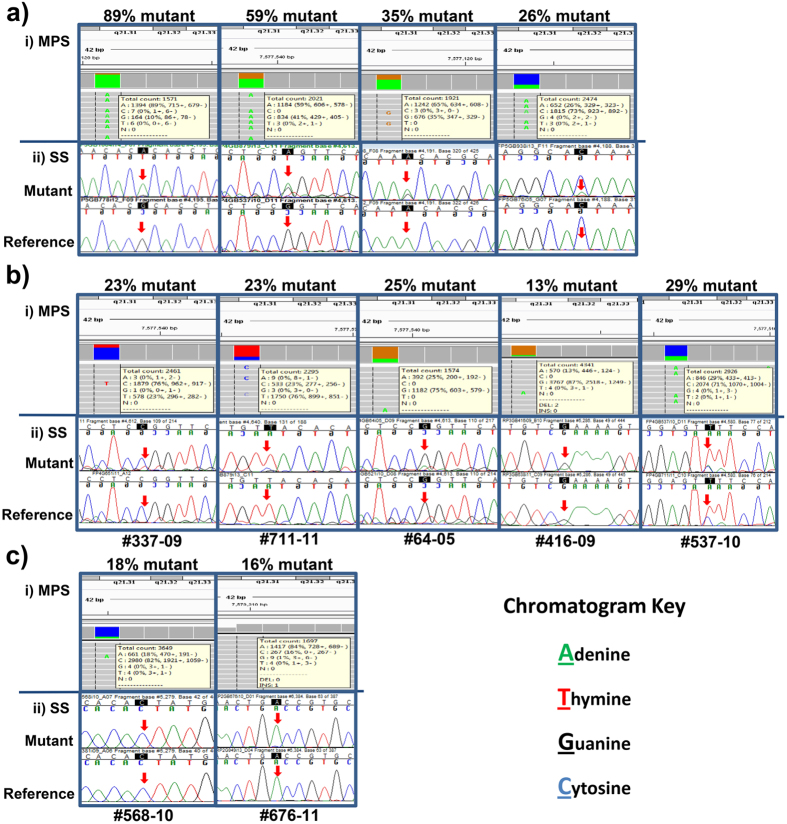
Comparison of the ability of next generation and Sanger sequencing to detect TP53 mutations.Top panels (a–c) display MPS data viewed using IGV software (i). Lower panels display Sanger sequencing (SS) chromatograms of mutant and wild-type reference samples viewed using Sequencher software (ii). Red arrows denote presence of mutations in SS, initially discovered by MPS. (a) Shows four mutations with frequencies of the mutant allele between 26–89% determined by MPS that were able to be detected by SS. (b) Shows five mutations with frequencies of the mutant allele between 13–29%, which were initially not detected by SS; however, with the knowledge of MPS results, were identified in the chromatograms. (c) Shows two samples with frequencies of the mutant allele between 16–18% determined by MPS that were unable to be detected at all in SS chromatograms.